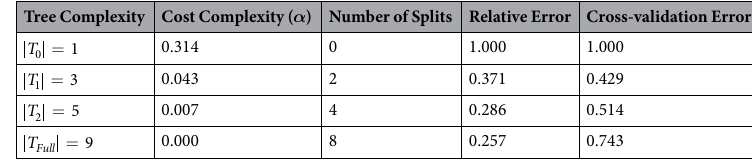
Table 5. The complexity table of recursive partitioning on simulated data. Pairwise p-value between terminal nodes. The diagonal of the table is one because the pairwise p-value of the terminal node itself is